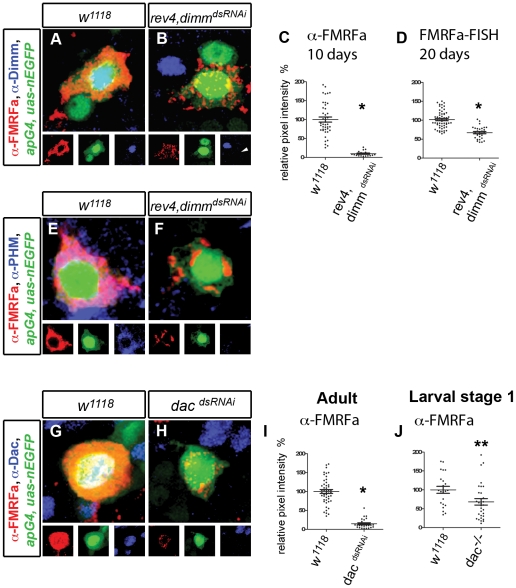

dimm maintains peptidergic phenotype and dac has an enhanced maintenance function.(A,B) Representative images of adult Tv4 neurons expressing FMRFa peptide (red), apGal4,UAS-nlsEGFP (green) and Dimm (blue) at A10 at 29°C. FMRFa is downregulated and Dimm is lost in rev4,dimmdsRNAi (B) compared to w1118 control (A). (C,D) Quantification of FMRFa peptide at A10 (C) and FMRFa transcript at A20 (D) in individual adult Tv4 neurons at 29°C. (C)* p<0.0001 rev4,dimmdsRNAi (n = 19) compared to w1118 control (n = 42). (D)* p<0.0001 rev4,dimmdsRNAi (n = 30) compared to w1118 control (n = 58). (E,F) Representative images of Tv4 neurons expressing mature FMRFa peptide (red), apGal4,UAS-nlsEGFP (green) and PHM (blue) in adult Tv4 neurons at A10 at 29°C. PHM is lost in rev4,dimmdsRNAi (n = 26) (F) compared to w1118 control (n = 30) (E). (G,H) Images of adult Tv4 neurons expressing FMRFa peptide (red), apGal4,UAS-nEGFP (green) and Dac (blue) at A10 at 29°C. FMRFa is downregulated and Dac immunoreactivity is lost in dacdsRNAi (H) compared to w1118 control (G). (I,J) Quantification of FMRFa peptide in individual adult Tv4 neurons at A10 at 29°C (I), and in L1 larval Tv4 neurons in dac null mutants. (J) * p<0.0001 dacdsRNAi (n = 26) compared to w1118 control (n = 47). (J) ** P = 0.02 dac−/− (n = 31) compared to w1118 control (n = 22). Genotypes: w1118 (UAS-dicer2/+; apGal4/+; tub-Gal80TS, UAS-nEGFP/+); rev4,dimmdsRNAi (UAS-dicer2/+; apGal4/rev4, UAS-dimmdsRNAi; tub-Gal80TS, UAS-nEGFP/+); dacdsRNAi (UAS-dicer2/+; apGal4/UAS-dacdsRNAi; tub-Gal80TS, UAS-nEGFP/+); dac−/− (dac3/dacDf(3L)EXEL 7066).